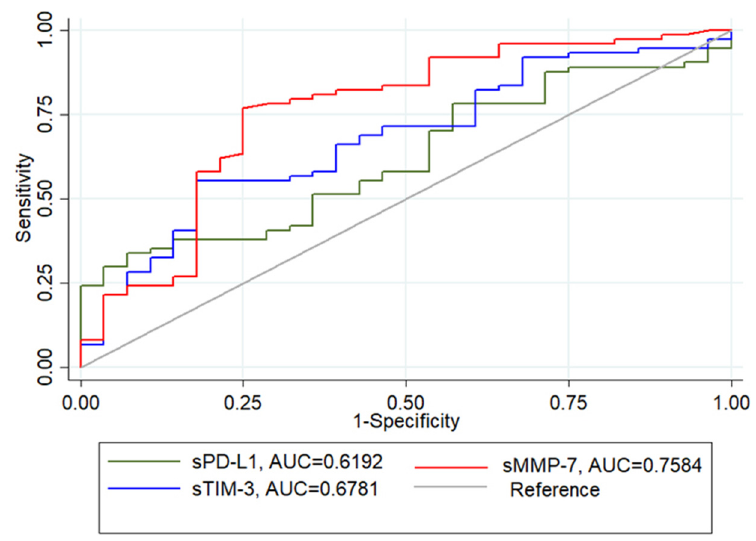
Figure 4. Analysis of circulating biomarkers (sMMP7, sPDL-1 and sTIM3) among IMV and NIMV using receiver operator characteristic (ROC) curves. AUC, area under the using receiver operator characteristic (ROC) curves. AUC, area under the curve.